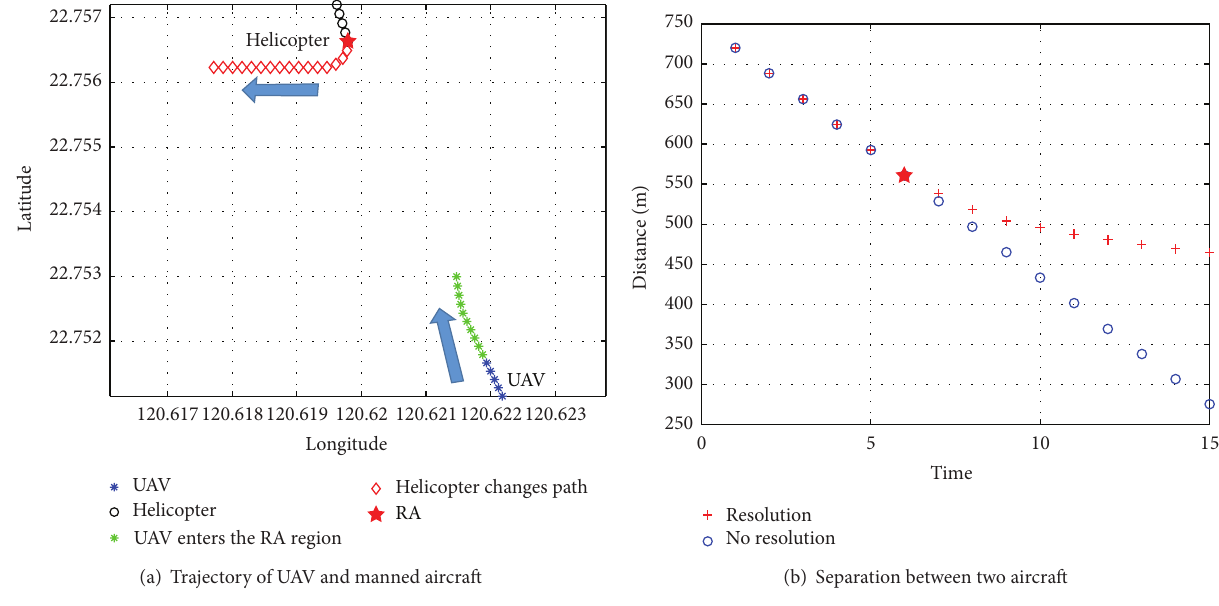
Figure 14: Avoidance trajectory of manned aircraft to